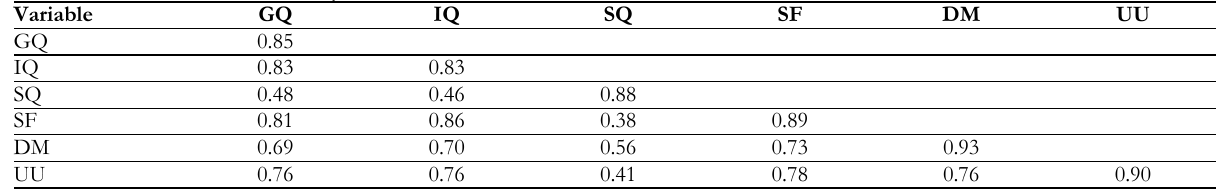
Table 2. Discriminant Validity